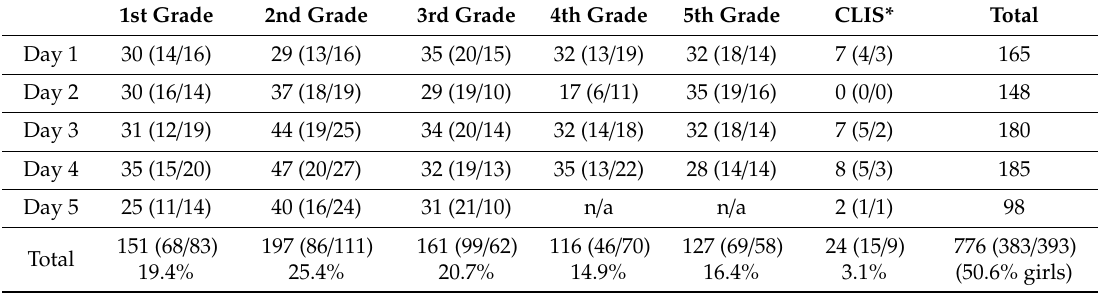
Table 2. Number of children by grade (boys/girls). * CLIS class (classe pour l'inclusion scolaire) is composed of children of different ages with school difficulties and training assistance.